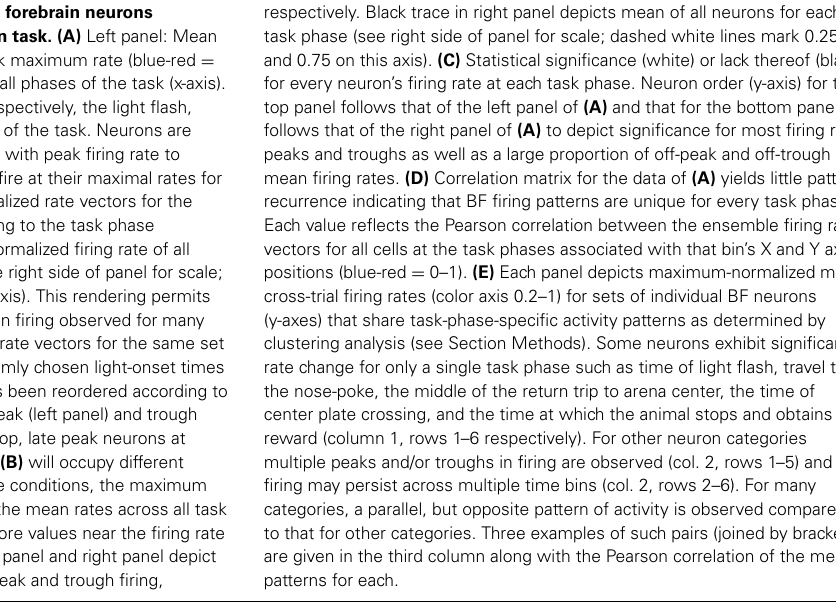
for the actual data against the cross-trial firing rates for the depicts the results of these tests. White pixels reflect those